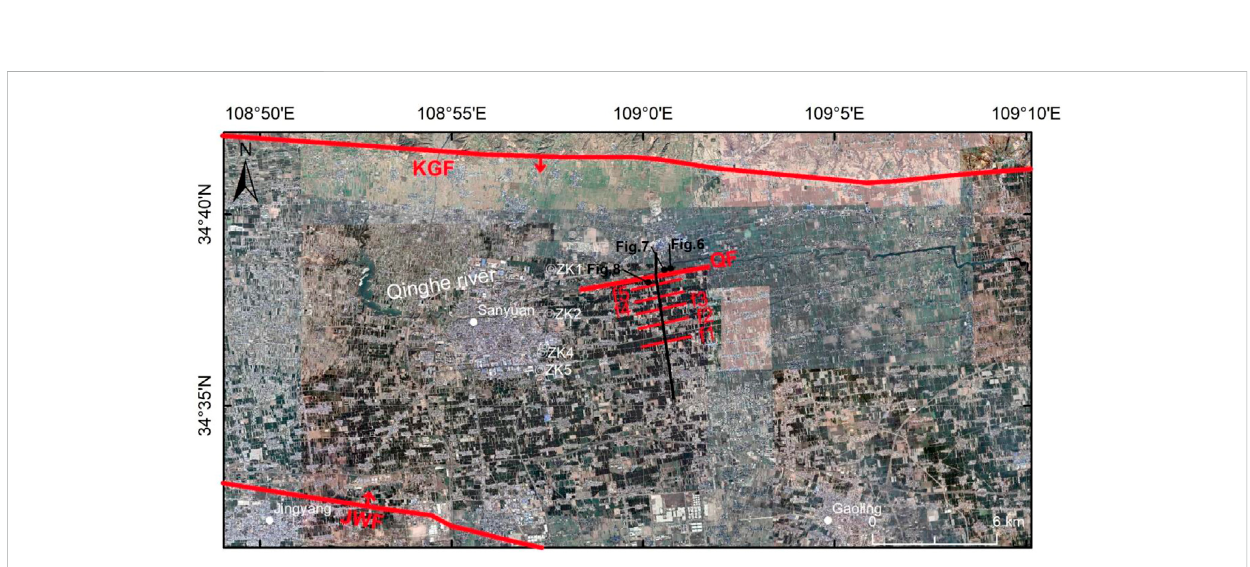
FIGURE 10 Morphostructuralmapofthestudyarea.Theredthicksolidlinerepresentsthemainfaults,theredthinsolidlinerepresentsthesurfaceprojectionof the secondary faults interpreted in this work, black solid line represents the shallow seismic survey line. The white bicentric circles represent the boreholes, and the black dots indicate the fi eld observation points in Figures 6 – 8. QF: Qinghe fault; KGF: Kouzhen-Guanshan fault; JWF: Jingyang- Weinan